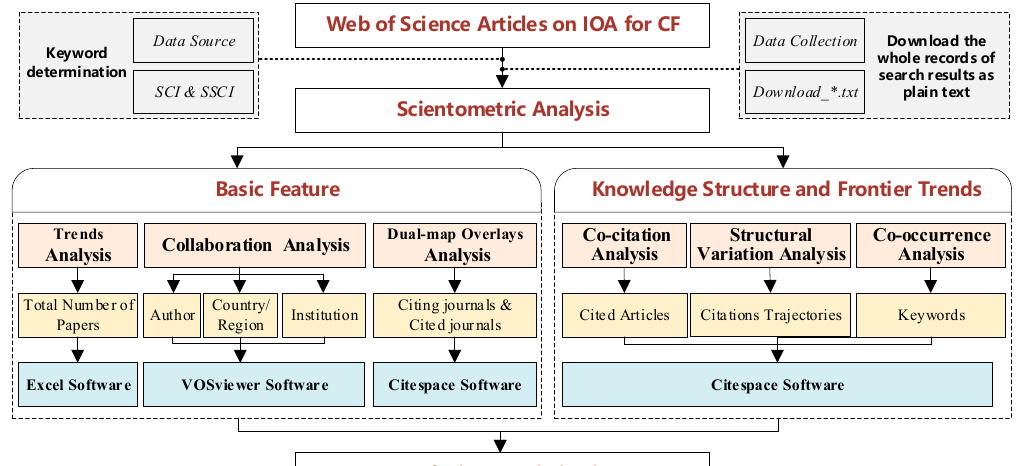
Figure 1. Outline of research